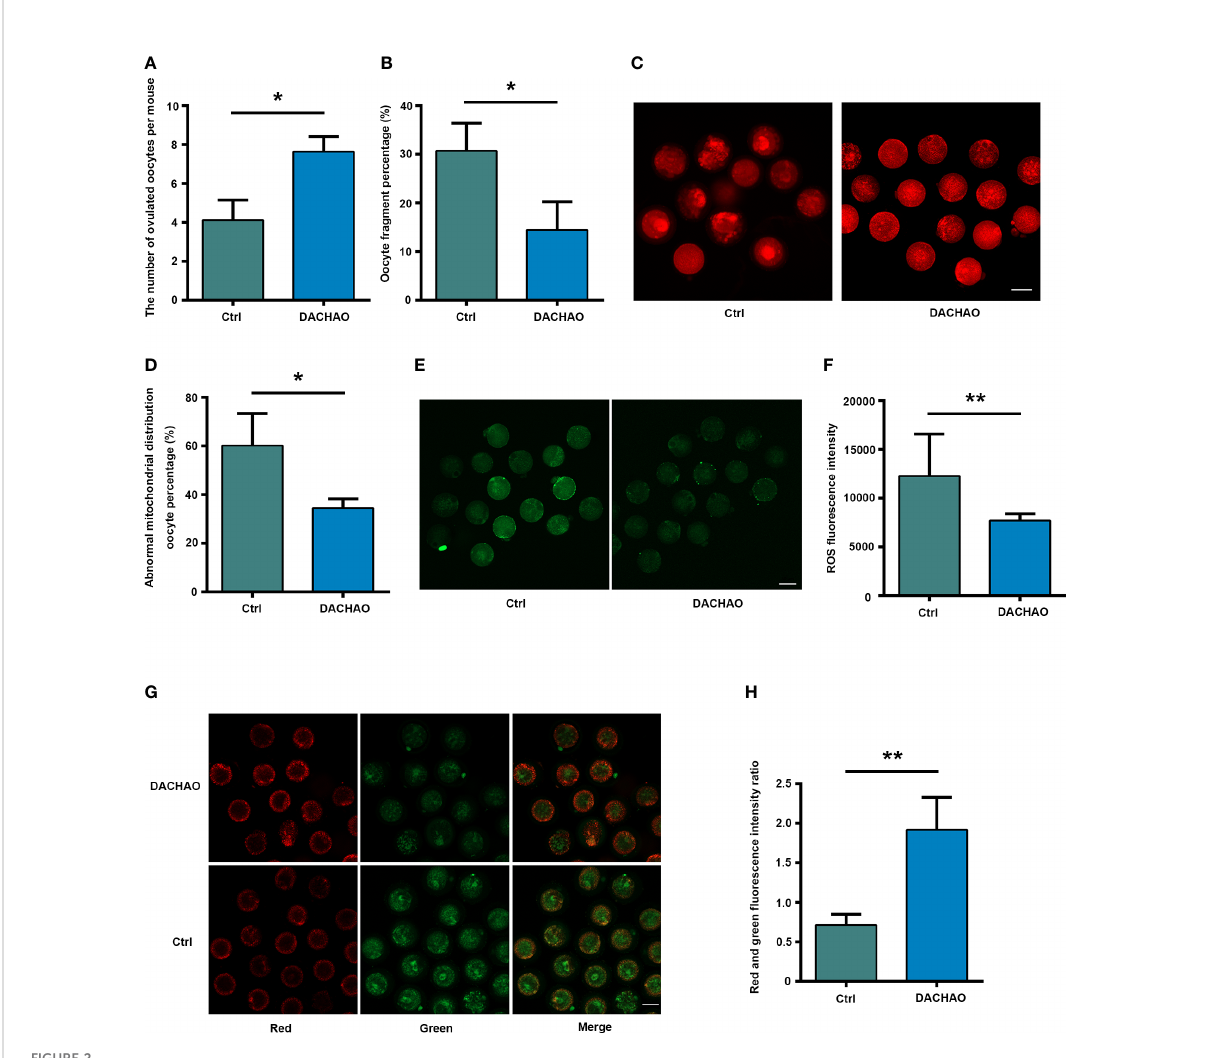
FIGURE 2 DACHAO administration improves both the quantity and quality of oocytes from aged mice. (A) Statistical graph of the number of ovulation after superovulation in each group (n=318). (B) Statistical graph of the ratio of oocyte fragmentation after superovulation in each group (n=318). (C) MitoTracker staining showed the mitochondrial distribution of oocytes in each group (n=71). (D) Statistical graph of abnormal mitochondrial distribution oocyte percentage in each group. (E) ROS fl uorescence staining showed the level of reactive oxygen species in oocytes in each group(n=60). (F) Statistical graph of gray value of ROS fl uorescence staining of oocytes in each group. (G) JC-1 staining showed mitochondrial membrane potential of oocytes in each group (n=64). (H) Statistical graph of the ratio of red-green fl uorescence in JC-1 staining in each group. Data are presented as means ± SEM of three independent replicates. *P < 0.05 and **P < 0.01, compared with the control group. n = the total number of oocytes in the 2 groups of 3 repetitions. All bars = 50 m